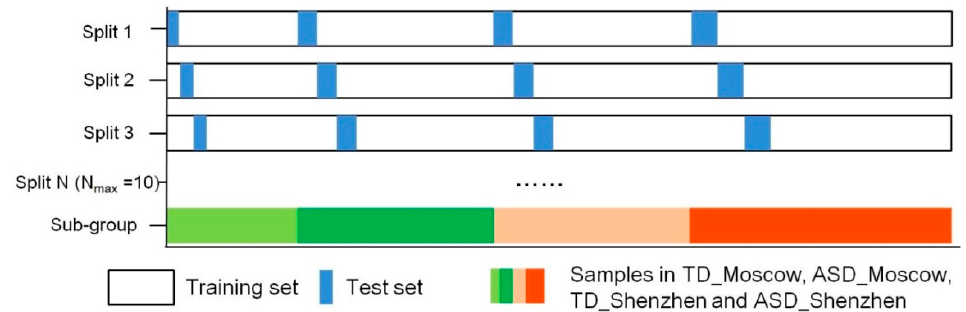
Figure 1. Stratified 10-fold cross-validation. All models were evaluated by stratified 10-fold cross-validation with the dataset divided into training and test sets. validation with the dataset divided into training and test